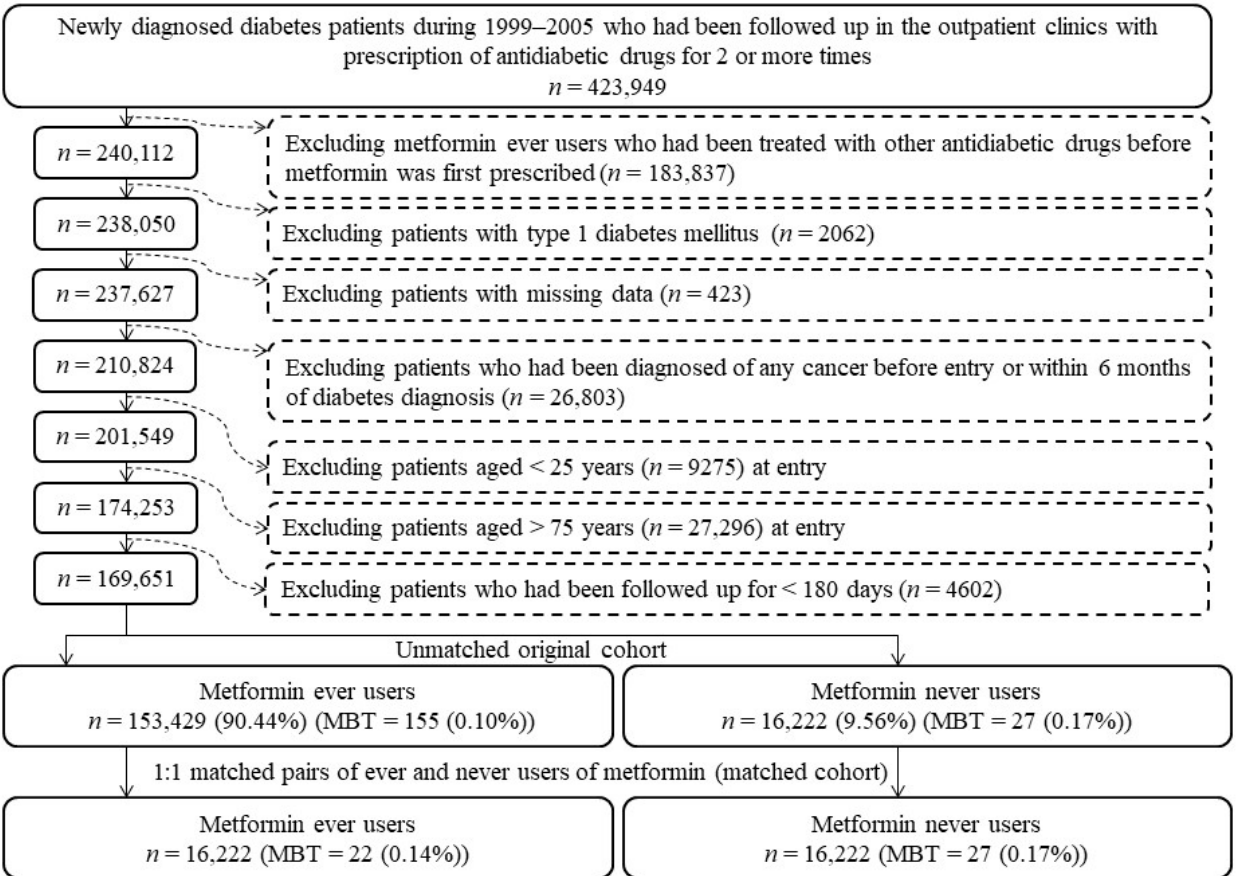
Figure 1. The step-by-step procedures followed to create an unmatched original cohort and a matched cohort from the reimbursement database of the National Health Insurance for the study. The matched pairs of ever users and never users of metformin were derived from the unmatched cohort based on propensity scores (MBT: malignant brain tumors).